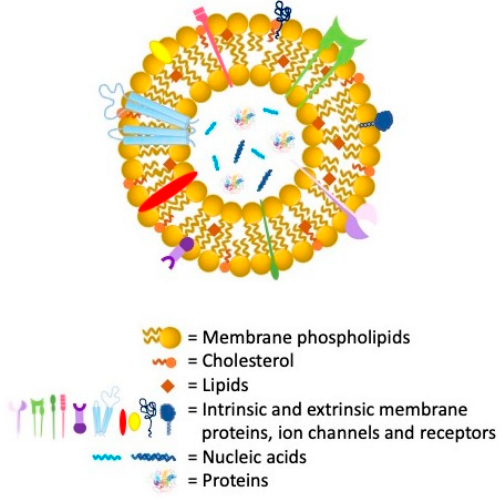
Figure 9. Schematic structure of extracellular vesicles.